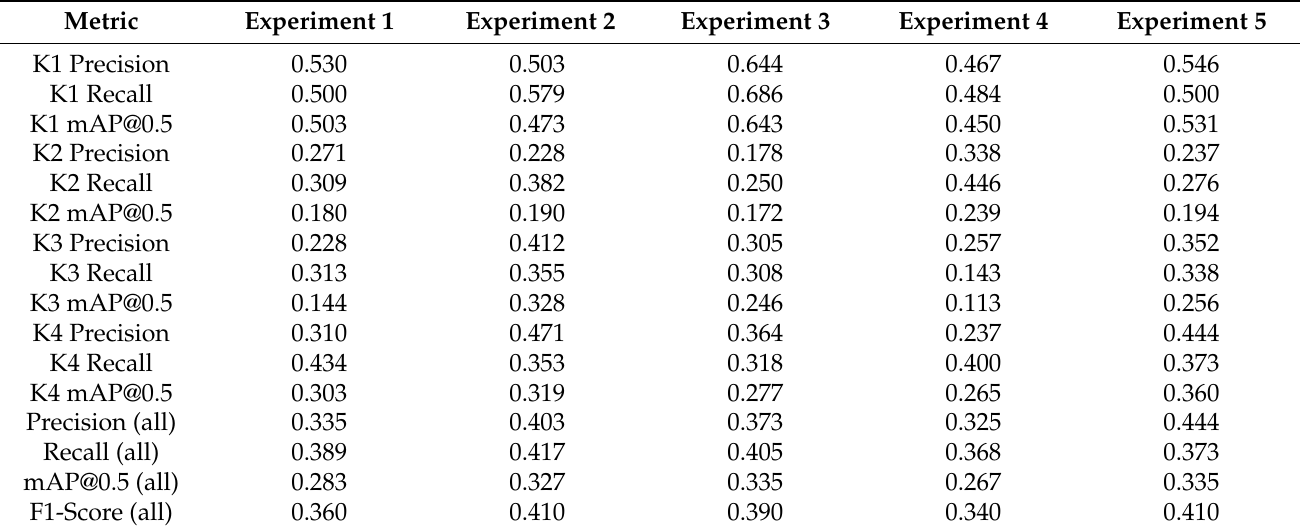
Table 7. Cross-validation results of a base model + classical augmentation